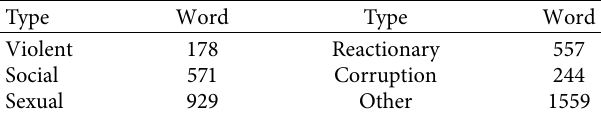
Table 2: The employed corpus for word detection.